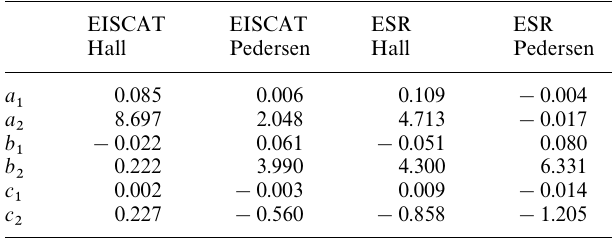
Table 3. The coefficients for our fitted law of conductances